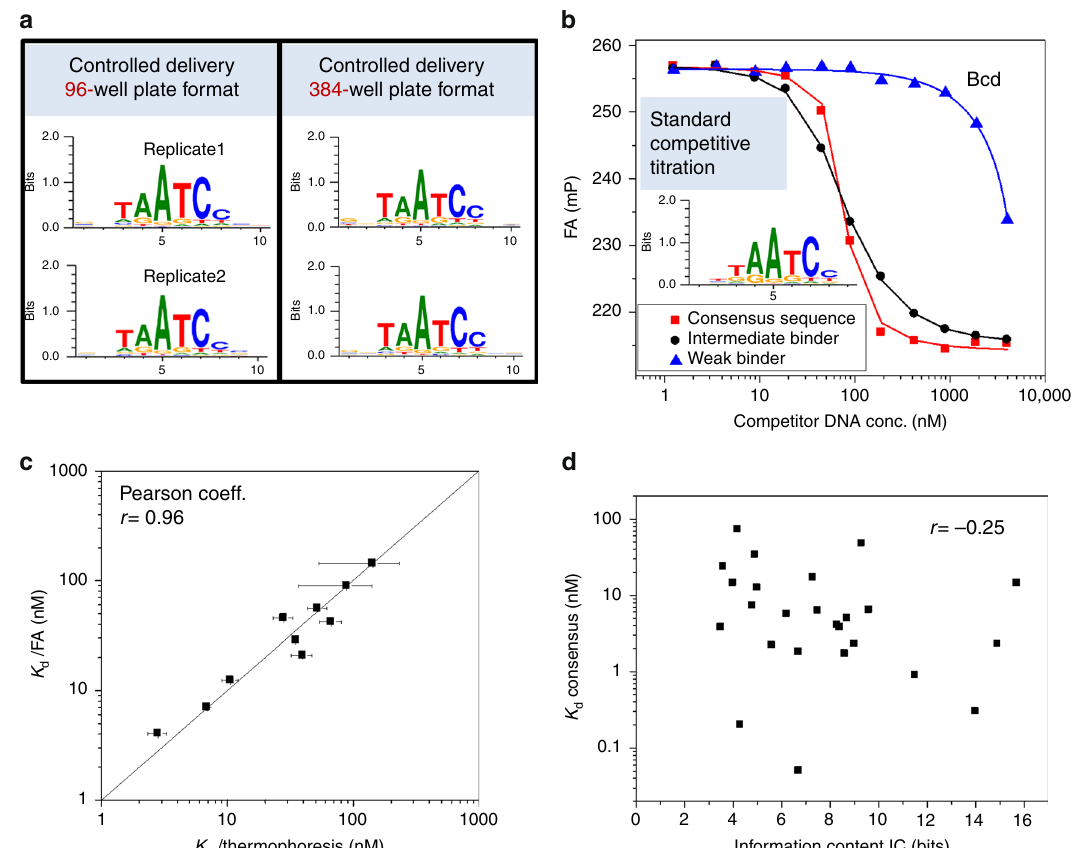
Fig. 2 Validation and reproducibility of the HiP-FA method and correlation between the dissociation constants and the information content. a Bcd binding motifs obtained from measurements in 96- (left) and 384- (right) well plates using automation. The mean CVs for the K D s were 5% and 16% for the 96- and 384-well plate formats, respectively. b Conventional competitive titration with HIP-FA of three competitor DNAs binding to Bcd with different af fi nity. The inset shows the Bcd binding motif obtained by conventional competitive titration (average of two replicates). c Scatter plot of K D s obtained by HIP-FA vs. MST, each measured in a competitive assay for BCD-DBD binding to 10 different competitor sequences. Error bars represent standard deviations of two replicate measurements. d Scatter plot of consensus sequence K D vs. information content (IC) of PWMs for the 26 TFs